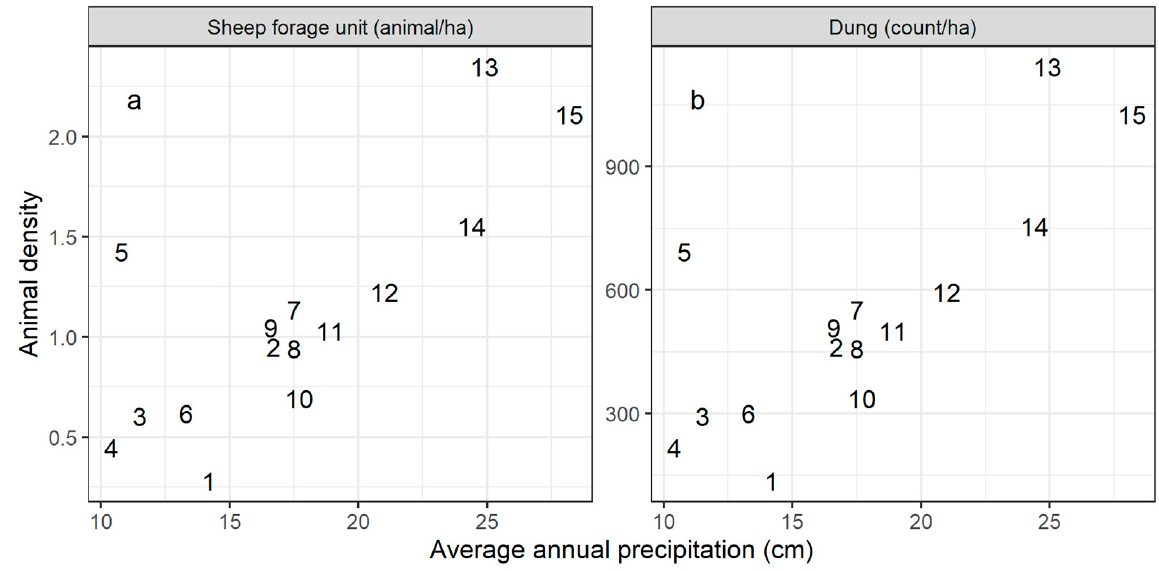
Figure A1. Animal density at each site vs. average annual precipitation at the site centroid. Baseline modeled animal density at each site, in sheep forage units per ha ( a ), was estimated from empirical dung counts surveyed at plots 1500 m from a grazing hotspot ( b ). Dung counts were transformed to a standardized livestock unit according to the species that each dung observation was attributed to; for dung count standardization methods, see [33].